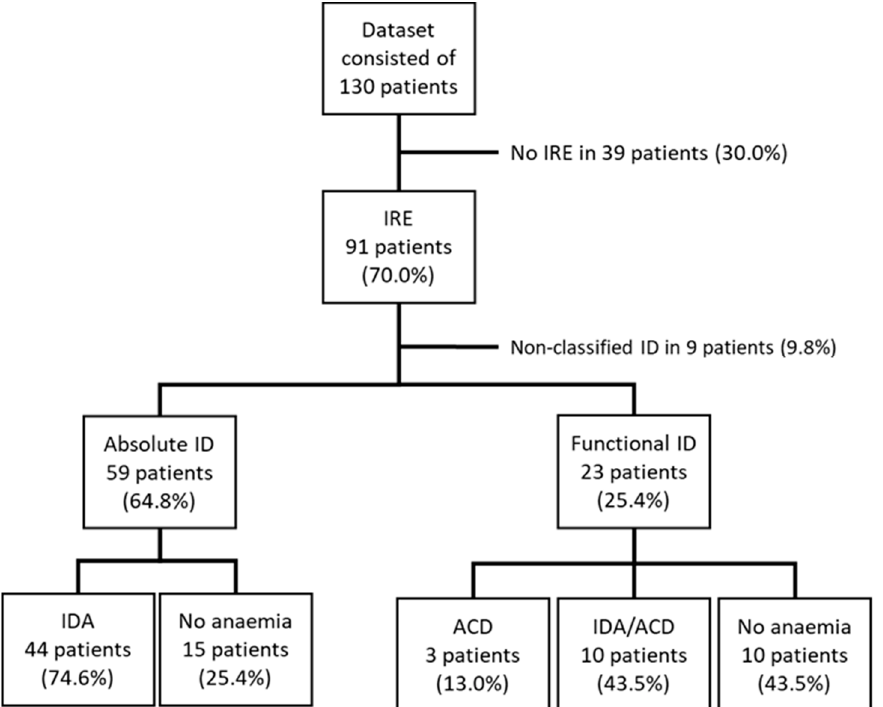
Figure 1. Prevalence of iron deficiency and anemia in patients with inflammatory bowel disease (IBD). Data are expressed as numbers (with percentages). ACD, anemia of chronic disease; ID, iron deficiency; IDA, iron deficiency anemia; IRE, iron-restricted erythropoiesis.